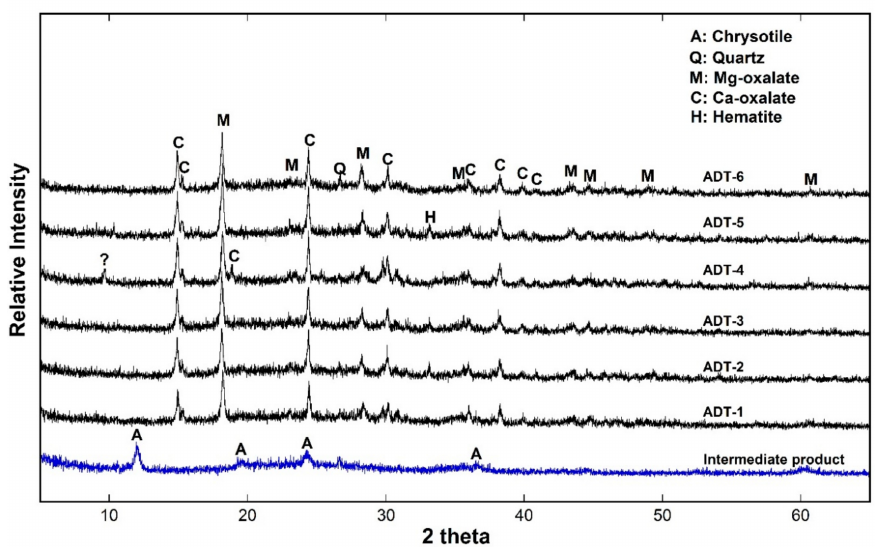
Figure 8. XRD results of the low temperature detoxification tests. Intermediate product indicates the solid sample obtained from the cement hydrates removal test at the conditions of HCl to solid ratio: 0.456 g/g, reaction time: 2 h, and solid to liquid ratio: 0.124